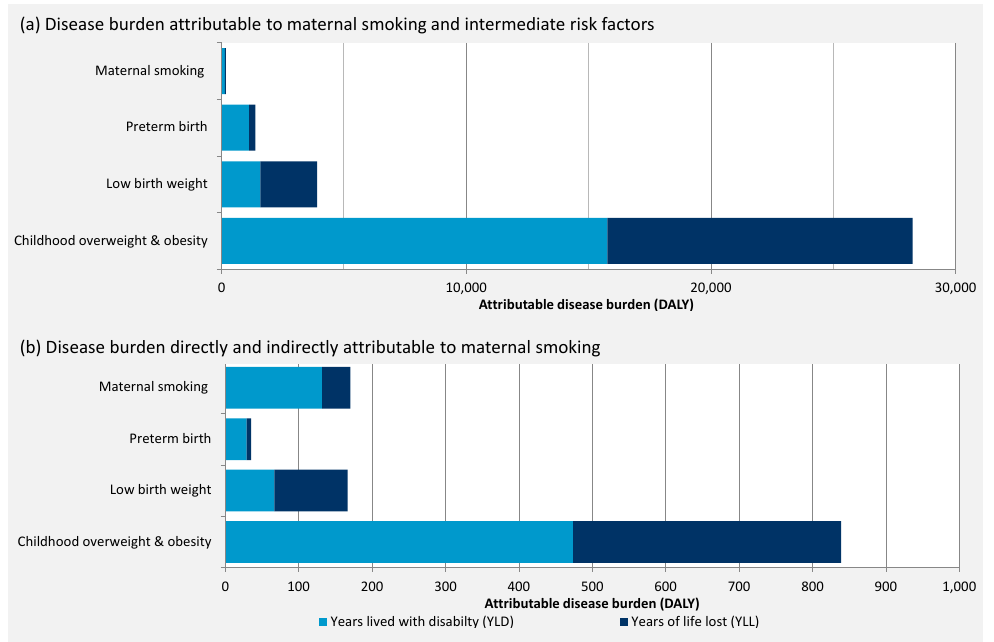
Figure 6. Maternal smoking and risk factor attributable disease burden divided by years lived with disease (YLD) and years lost due to premature death (YLL); ( a ) direct impact; ( b ) direct and indirect impact of maternal smoking.